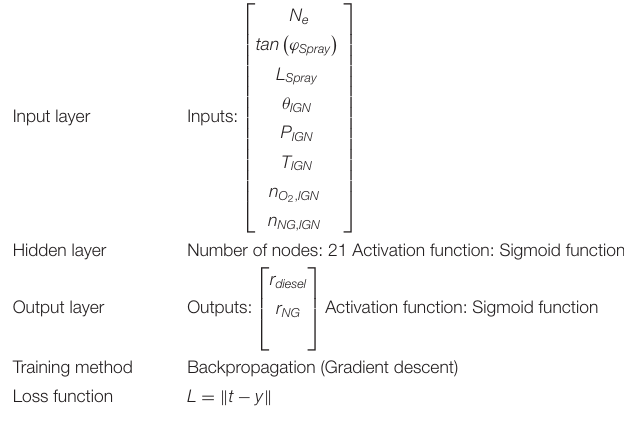
Number of nodes: 21 Activation function: Sigmoid function Activation function: Sigmoid function Training method Backpropagation (Gradient